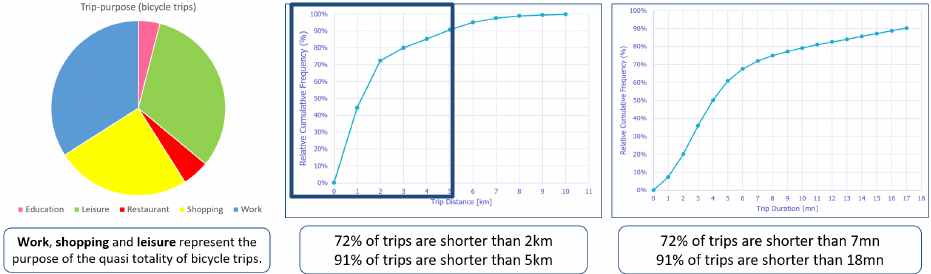
Figure 4. Statistics about bicycle usage in the study area: activities, travel distance and travel